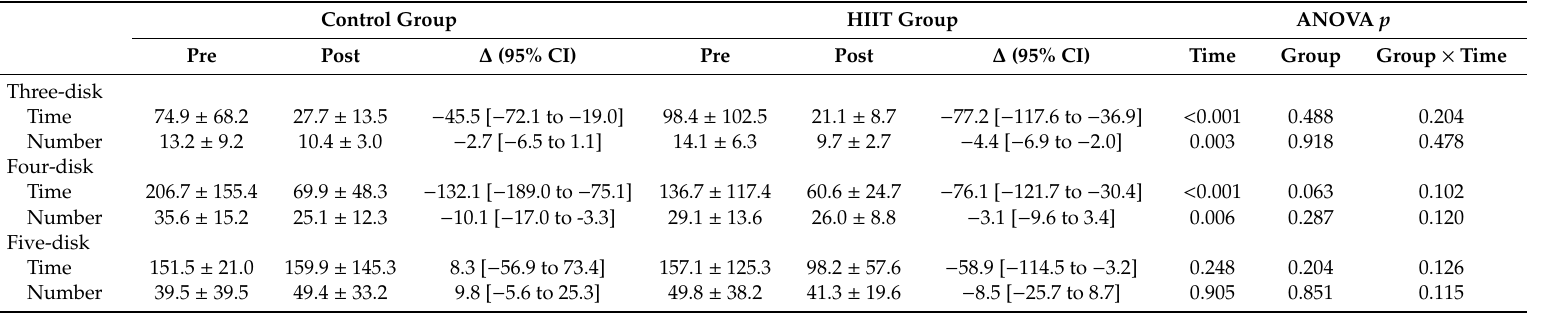
Table 4. Changes in the Tower of Hanoi test after training